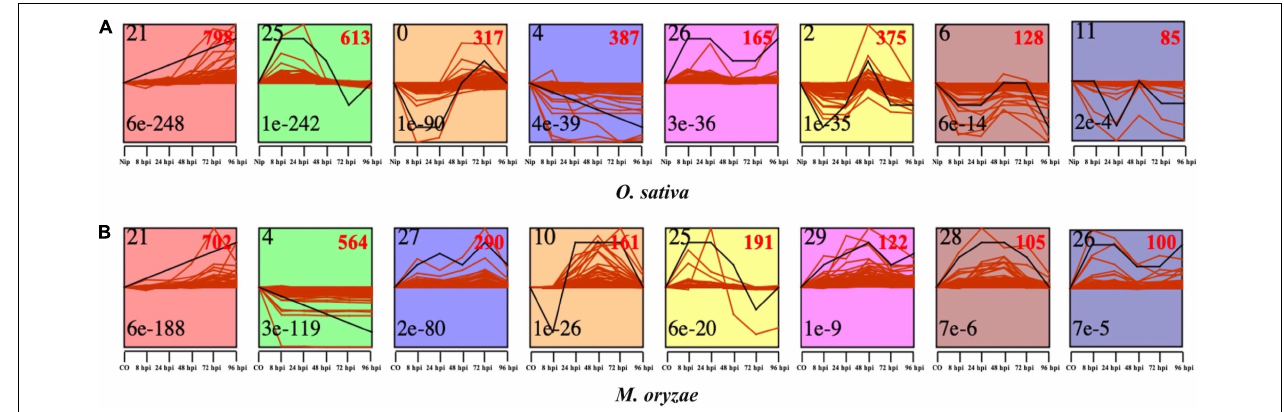
FIGURE 3 | Short Time-series Expression Miner (STEM) toolkit identified the temporal expression profiles of CDEGs in O. sativa (A) and M. oryzae (B) with a p -value < 0.05. The number on the top left corner of each profile box was Profile ID assigned by STEM, the number on the bottom left represents the adjusted p -value, and the number on the top right corner represents the CDEGs count of each cluster.